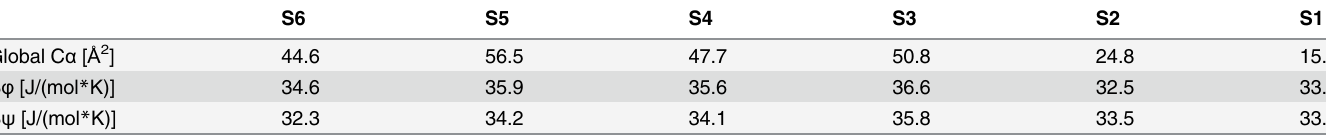
Table 1. Sub-pocket-wise global backbone B-factors for holo simulations (Global C α ) and dihedral entropy values S φ and S ψ . Sub-pocket average global backbone B-factors, S φ and S ψ show S1 and S2 sub-pockets as the most rigid sub-pockets. Sub-pockets S3-S6 show varying